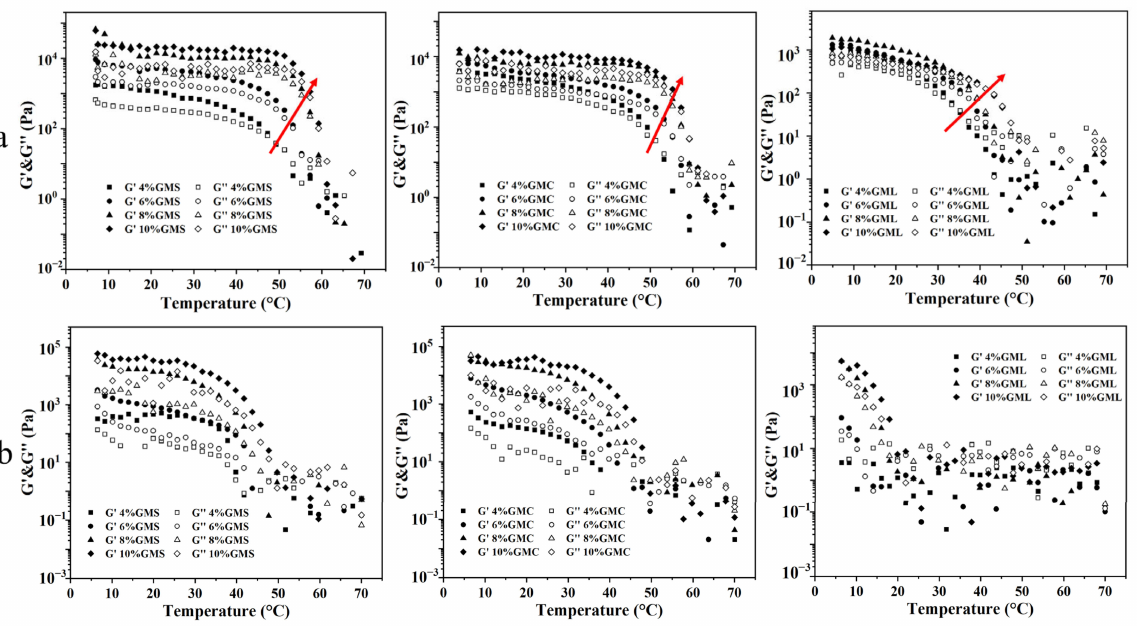
Figure 3. The storage modulus G (cid:48) and loss modulus G (cid:48)(cid:48) values during heating ( a ) and cooling ( b ) process. The red arrow indicates the direction in which the intersection of G (cid:48) and G (cid:48)(cid:48) moves from low to high MAG